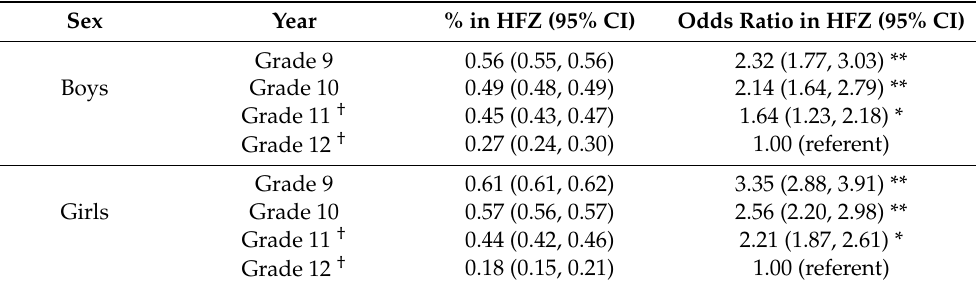
Table 3. Estimated proportion and odds ratio of youth in healthy fitness zone (HFZ).